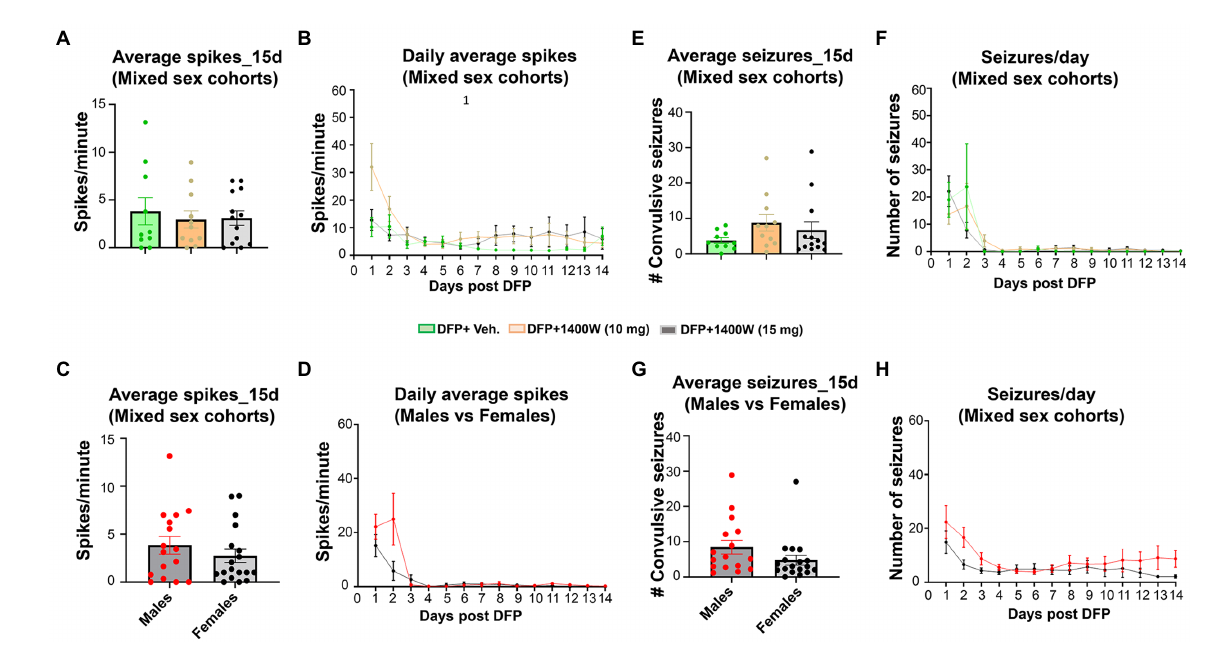
FIGURE 10 The effects of DFP and 1400W on epileptiform spikes and SRS during the 15 days post-exposure. Epileptiform spikes were compared in mixed sex cohorts and between males and females (A–D) . There were no significant differences in the epileptiform spike rate between any treatment groups in mixed sex cohorts (A,B) or between males and females (C,D) . Electrographic seizures were also compared in mixed sex cohorts and between males and females (E–H) . There were also no significant differences in the electrographic seizures (SRS) between any treatment groups in mixed sex cohorts (E,F) or between males and females (G,H) . One-way ANOVA with Tukey’s post-hoc for multiple comparisons. ( A,B ; n = 10– 13), ( C,D ; n = 16–18), ( E,F , n = 10–13), ( G,H ; n =